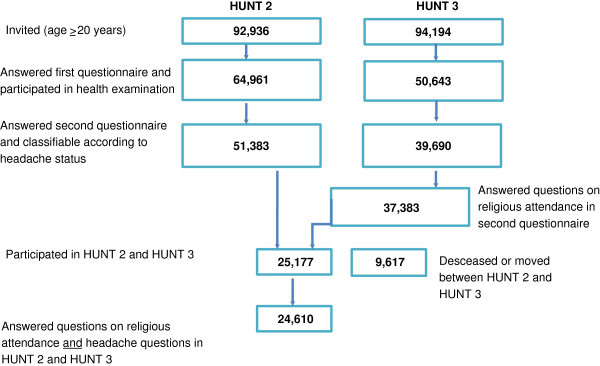
Flow diagram of the study population.